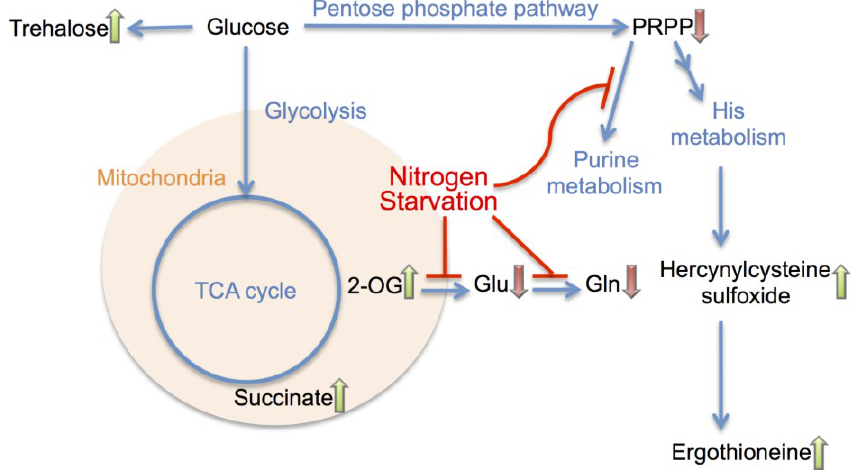
Figure 4. A summary diagram of metabolomic changes in S. pombe cells at the onset of nitrogen